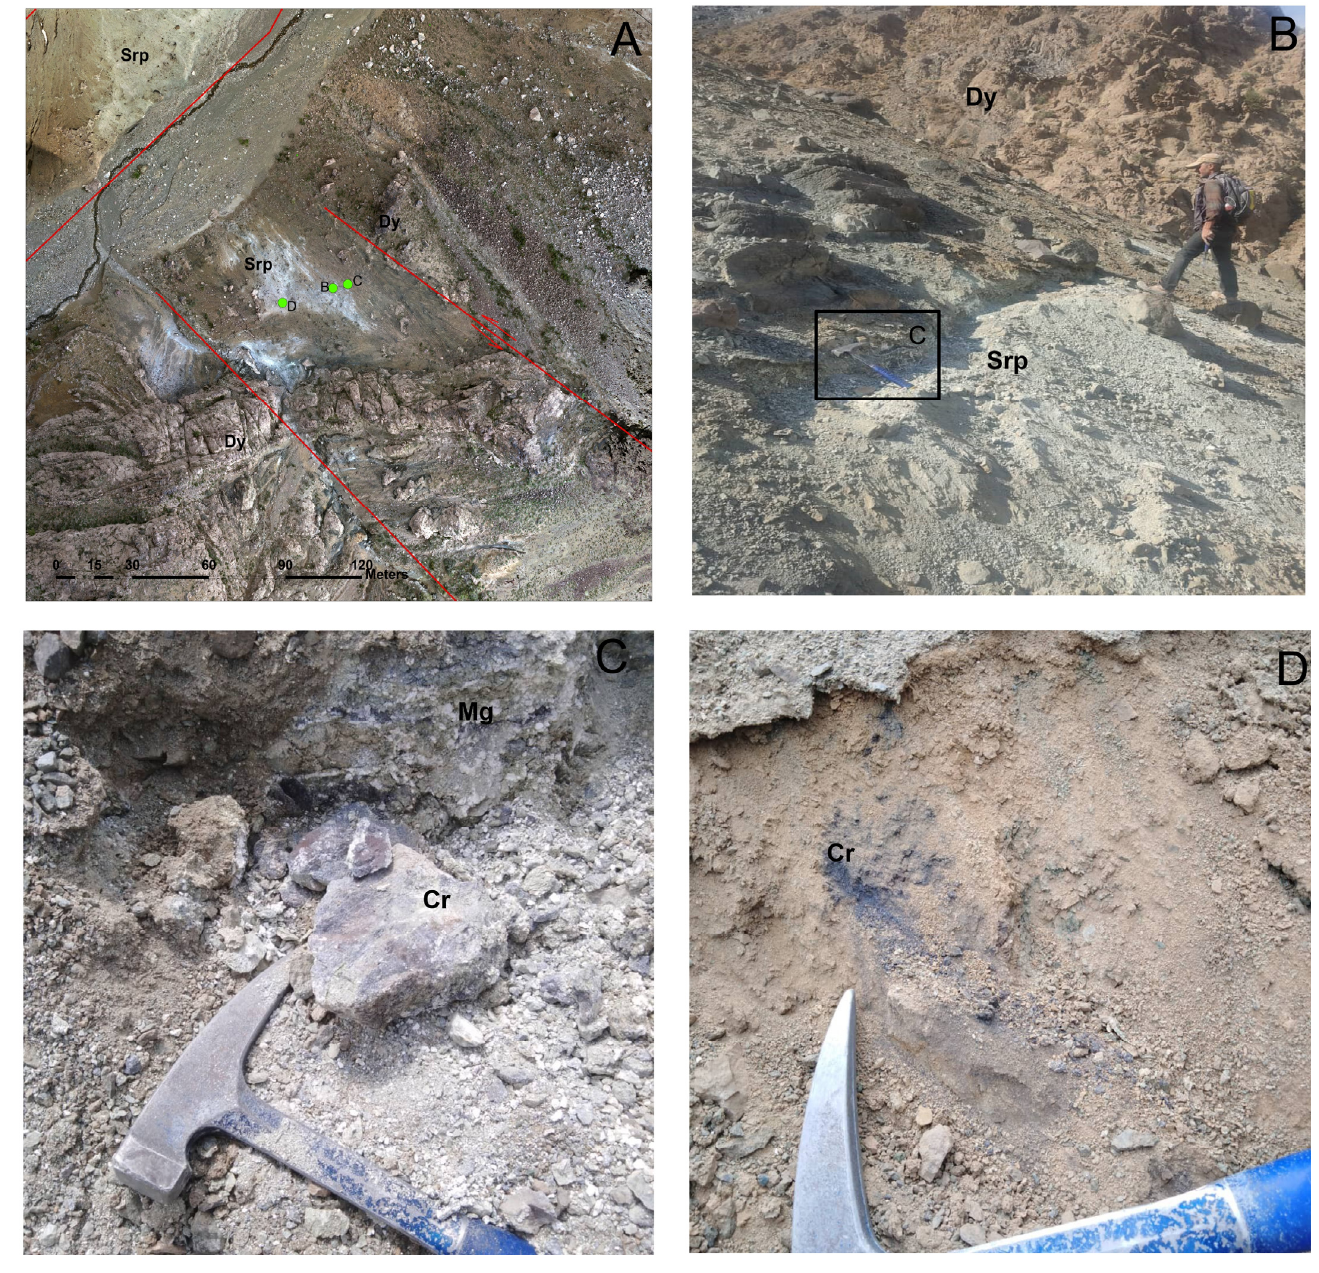
Figure 13. Correlation of explored chromite outcrops and indexes with the lithological unit (serpen- tinites), ( A ) the aerial view of the black circle in Figure 11 as a promising area for chromite prospecting. The location of Figure 13B–D are shown as points with the same label ( B ) outcrop of serpentinite and strike of chromite index, which is seen as nodules along the handy trench. The inset rectangle shows the location of Figure 13C. ( C ) close view of one of the chromite nodules accompanied by magnesite balls easily separated from the highly altered serpentinite. ( D ) outcrop of chromite beneath the iron Ni-rich serpentinite soil. Abbreviations are Srp (serpentinite), Dy (mafic dyke), Cr (chromite), Mg (magnesite).